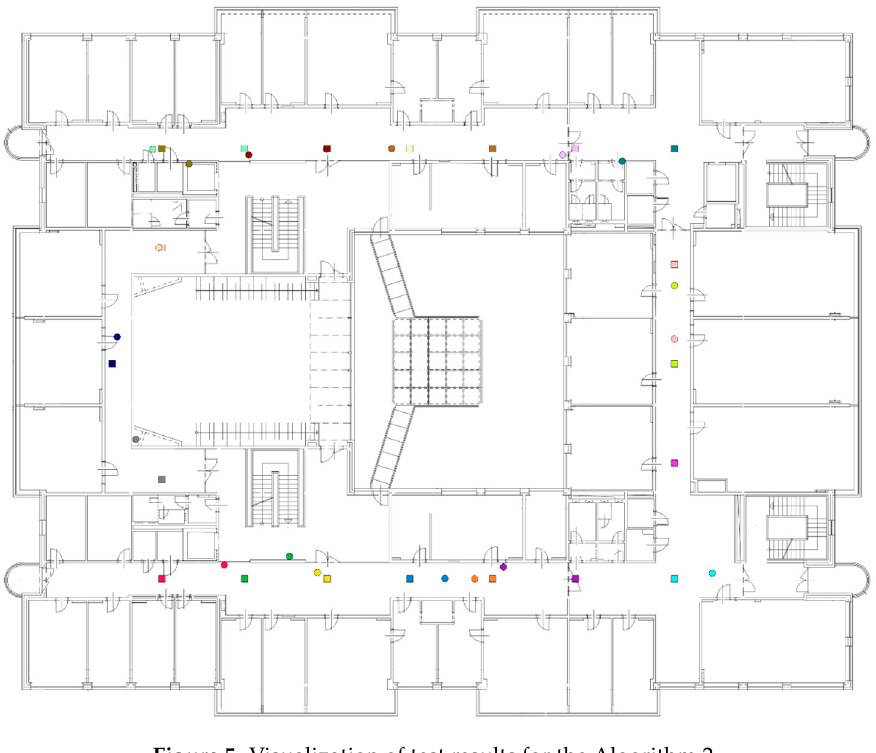
Figure 5. Visualization of test results for the Algorithm 2. Mathematics 2020 , 8 , x FOR PEER REVIEW